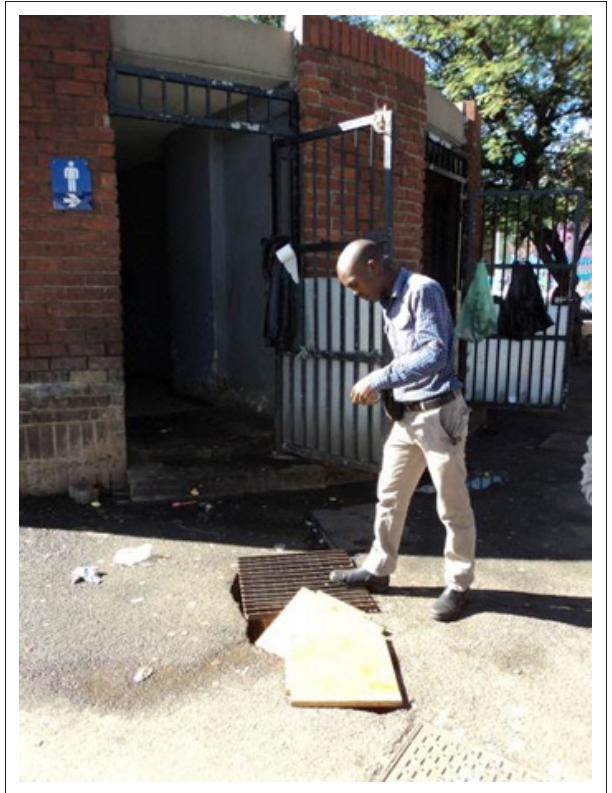
FIGURE 7: Entrance of public ablution facility with large pothole covered with wood, and absence of ramp leading into ablution